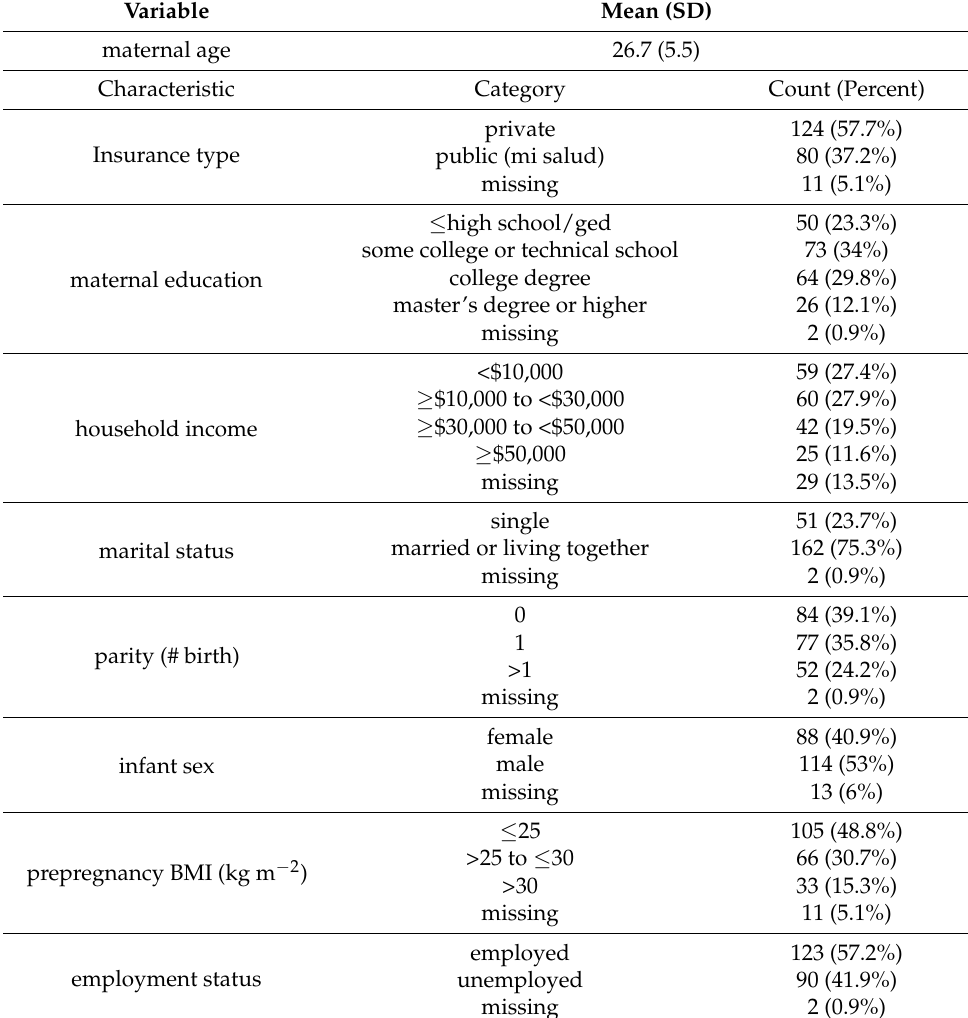
Table 1. Demographic characteristics of n = 215 pregnant women from Puerto